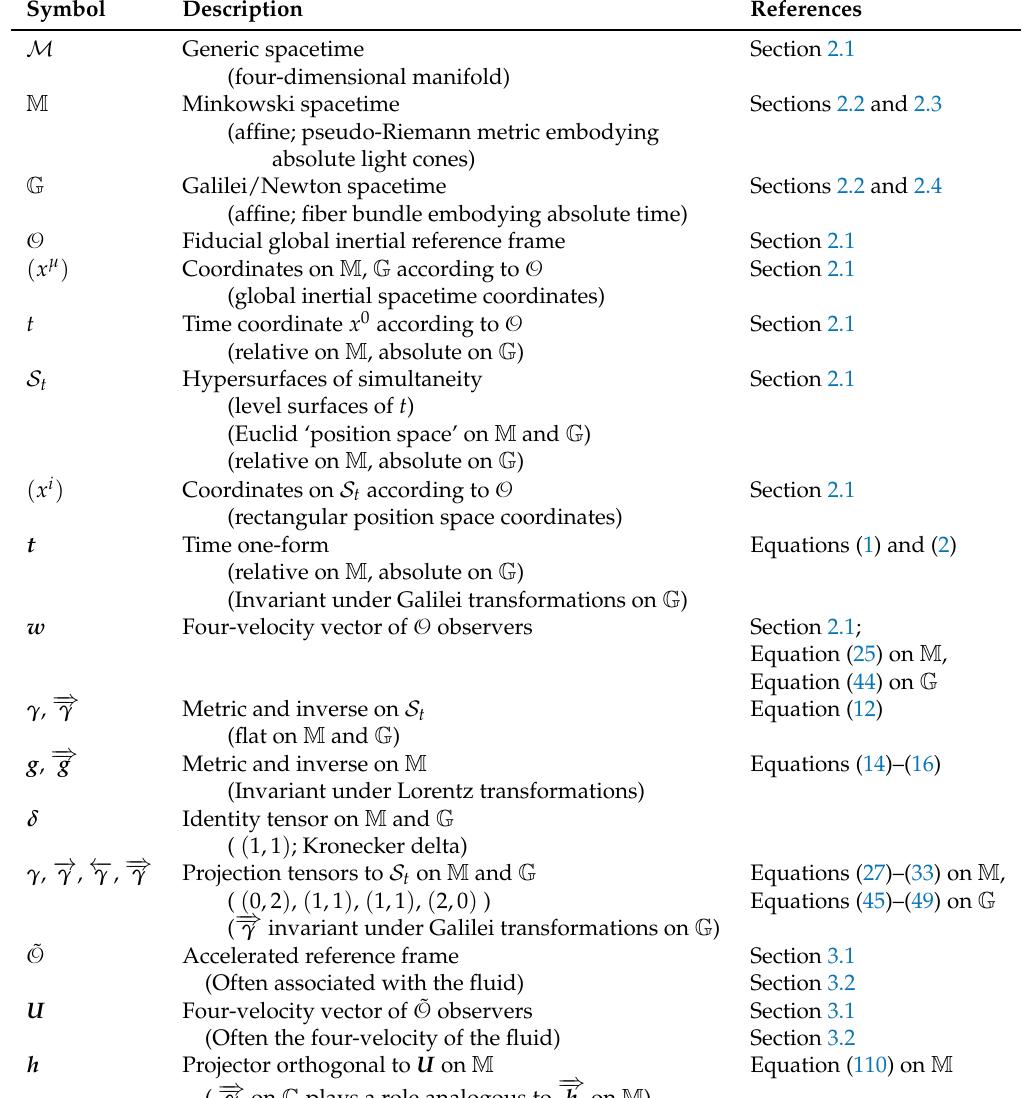
Table 1. Geometric entities characterizing 3 + 1 Minkowski and Galilei/Newton